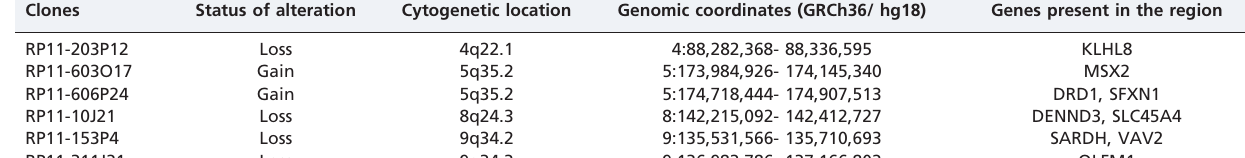
Table 1 - Clones that exhibited copy number variation detected through aCGH screening of the patient’s genome.